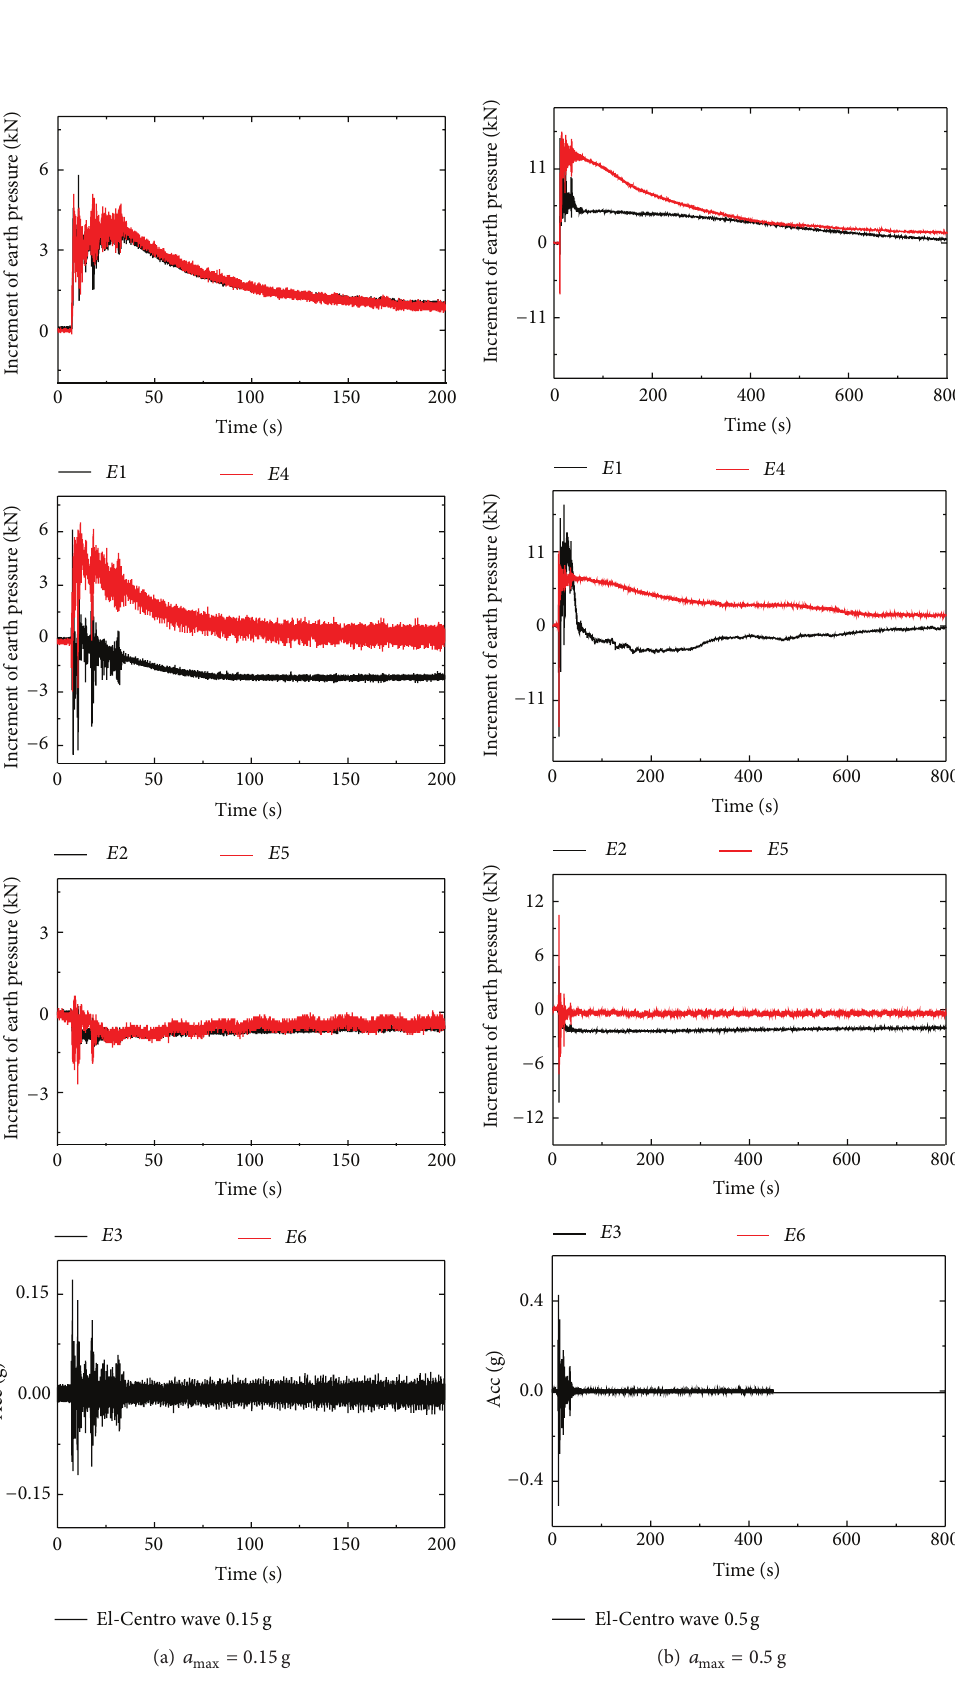
Figure 6: Increment of earth pressure in test 1 under El-Centro